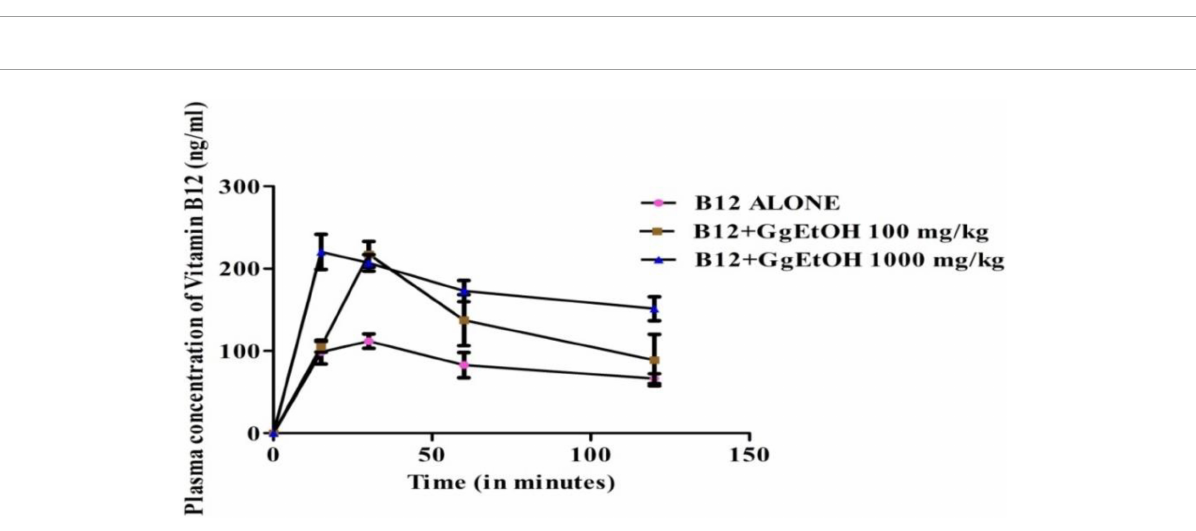
FIGURE3 (A) Concentration vs. time profile of B12 transport across gut sacs (from mucosal to serosal compartment). Each point represents mean ± SD (n = 4). (B) Effect of GgEtOH on intestinal permeation enhancement of Vitamin B12 in everted gut sac assay. B12 alone (sacs incubated with Cyanocobalamin only at concentration of 100 µ g/ml), B12+GgEtOH 250, B12+GgEtOH 500 [Sacs incubated with combination of Cyanocobalamin (100 µ g/ml) and GgEtOH at 250 and 500 µ g/ml concentration, respectively]. ** p < 0.01, *** p < 0.001 with respect to B12 alone ( n = 4).